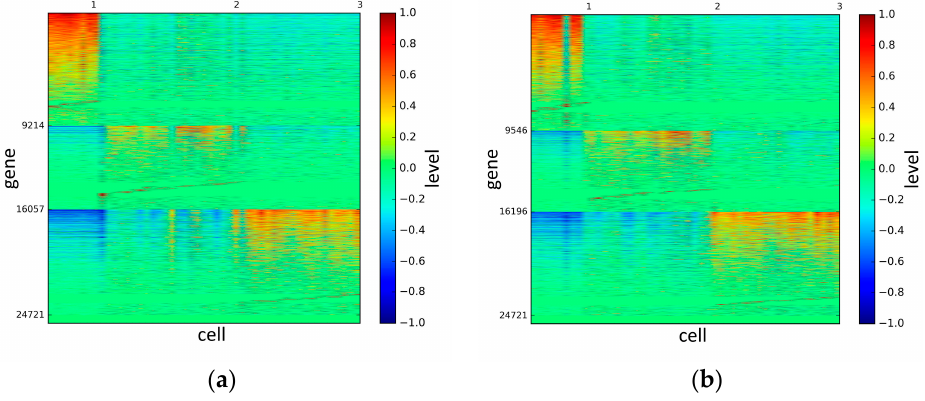
Figure 2. The heat maps of Biase datasets.